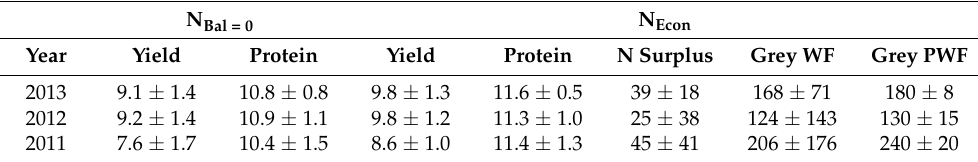
(Figure 3a). N surplus and the difference of N fertilizer supply between N Econ and N Bal = 0 ( ∆ N) were linearly correlated and N surplus was, as indicated by the slope of the linear regression function, 61.6% of ∆ N. Higher N application rates at N Econ compared to N Bal = 0 resulted in exponentially increasing grain yields (Figure 3b). Grain yields at N Econ , as compared to N Bal = 0 , increased on average